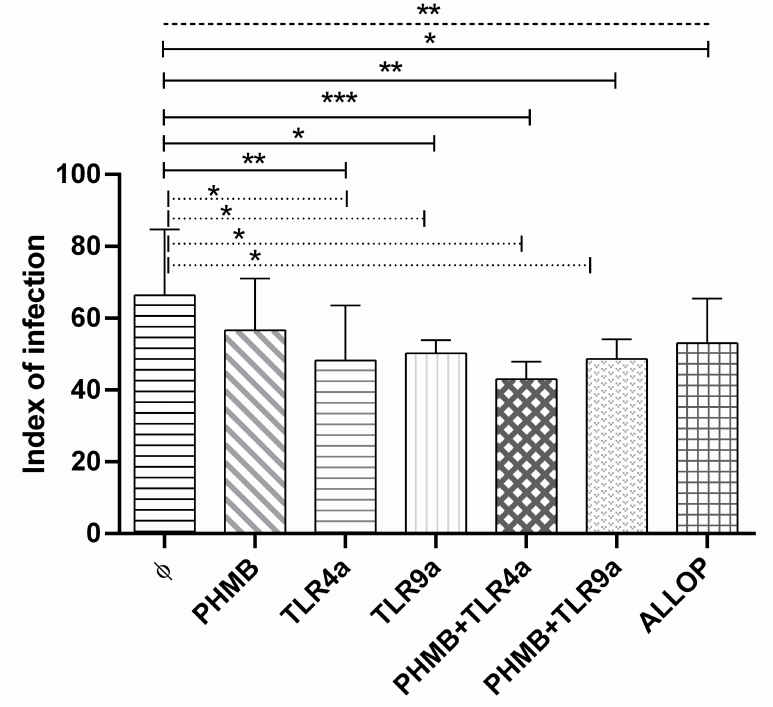
Figure 3. Infection index of in vitro L. infantum macrophage infection after 24 h treatment with the di ff erent conditions: Medium alone (Ø), Polyhexamethylene biguanide alone (PHMB), MPLA Toll-like receptor agonist 4 (TLR4a), PHMB plus TLR4a (PHMB + TLR4a), CpG ODN Toll-like receptor agonist 9 (TLR9a), PHMB plus TLR9a (PHMB + TLR9a), and allopurinol (ALLOP). Significant results are described as * 0.05 > p > 0.01, ** 0.01 > p > 0.001, *** 0.001 > p > 0.0001. Lines in graphic represent ANOVA (dashed lines), Dunnett´s test (solid lines), and Wilcoxon signed-rank test (dotted lines). A lower infection index was found in the infected macrophages treated with PHMB plus TLR4a (mean ± sd of 42.9 ± 4.2, Wilcoxon signed-rank test: p = 0.043), and PHMB plus TLR9a (mean ± sd of 48.5 ± 4.9, Wilcoxon signed-rank test: p = 0.042) and also in TLRa treatments alone, TLR4a (mean ± sd of 48.2 ± 13.4, Wilcoxon signed-rank test: p = 0.041) and TLR9a (mean ± sd of 50.1 ± 3.3,